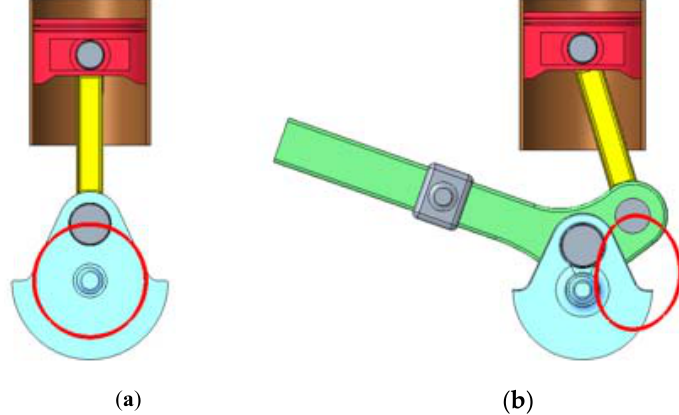
Figure 3. Trajectory of the con rod big end for a complete rotation of crank shaft: ( a ) classic; ( b ) VCR.